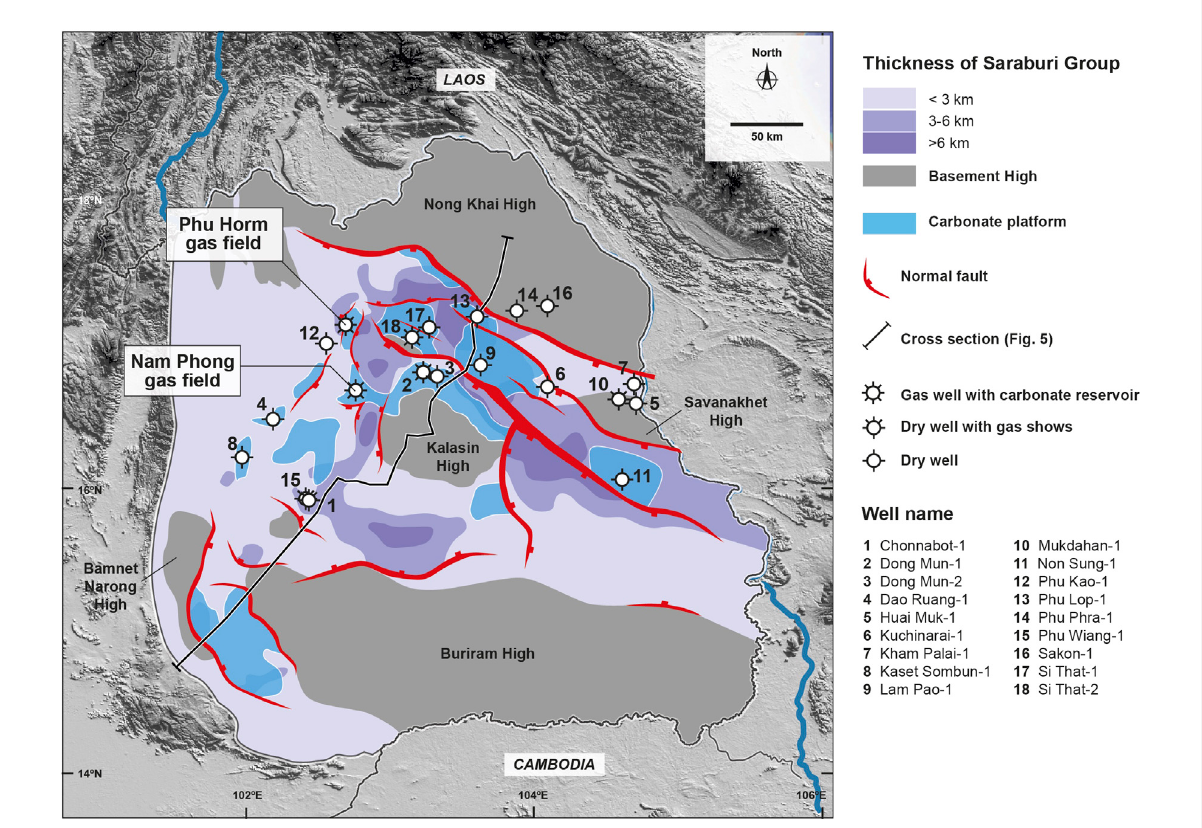
FIGURE 9 Mapshowinglocationsofselectedpetroleumexplorationwells,gas fi elds,basementfaulting,andthethicknessoftheSaraburiGroup(modi fi ed from Booth and Sattayarak, 2011; Minezaki et al., 2019). The main petroleum targets are located on the Permian carbonate